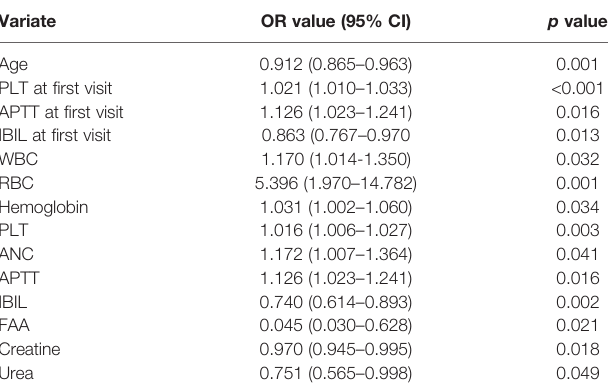
TABLE 4 | Univariate